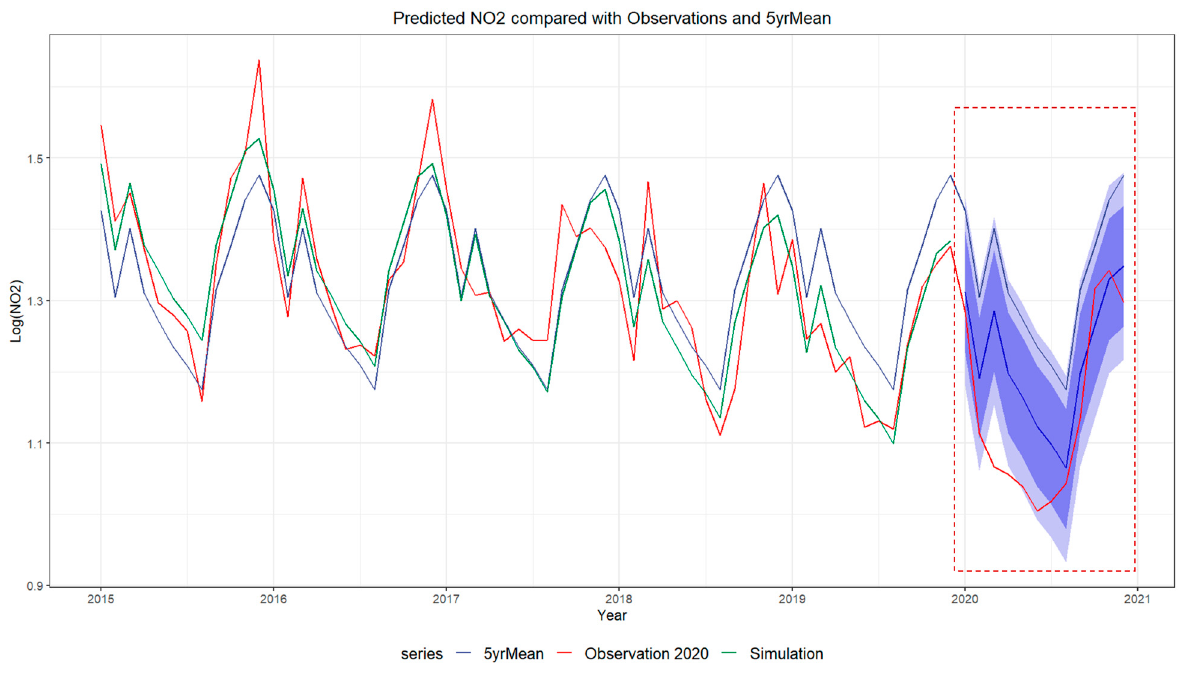
Figure 5. Comparison between observation and expectation (prediction line). The multiple linear regression model prediction line (blue line with buffer range) is shown as the base map (the light blue buffer is the 95% confidence interval), superimposed on the previous 5-year average as the reference baseline (grey blue line, namely, 5yrMean) and the regression simulation fitting curve (light grey line), compared to the actual observed value (red line).